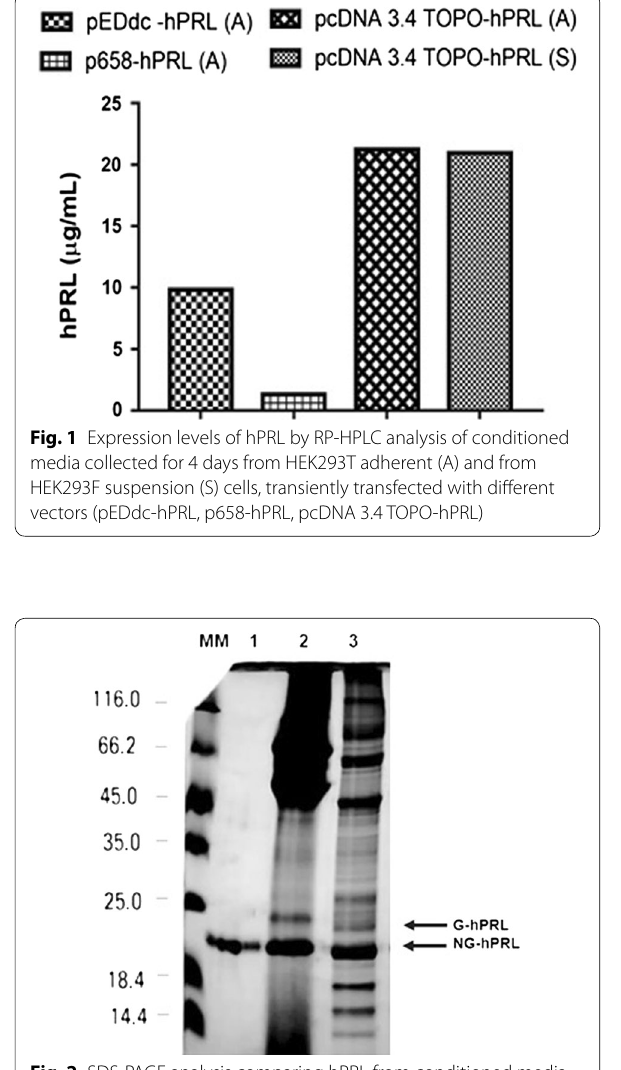
Fig. 2 SDS-PAGE analysis comparing hPRL from conditioned media collected from HEK293T adherent cells with that from HEK293F suspension cells, all transiently transfected with the pcDNA 3.4 TOPO-hPRL vector, after SP-Sepharose FF purification step. MM, molecular mass marker; (1) internal reference preparation of NG-hPRL from E. coli ; (2) hPRL obtained from HEK293T adherent cells; (3) hPRL obtained from HEK293F suspension